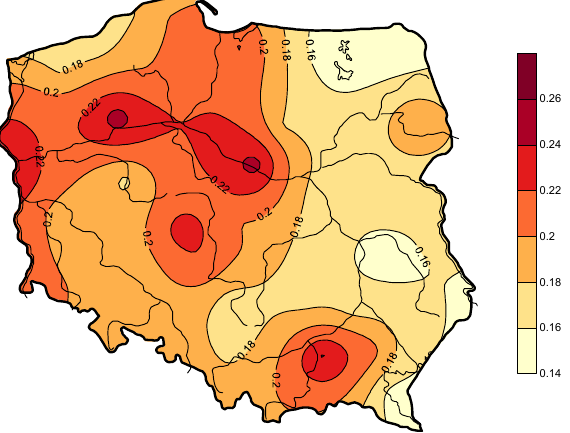
Figure 10. Isarithms of the coe ffi cient of variation of yearly precipitation totals in Poland in 2001–2018.